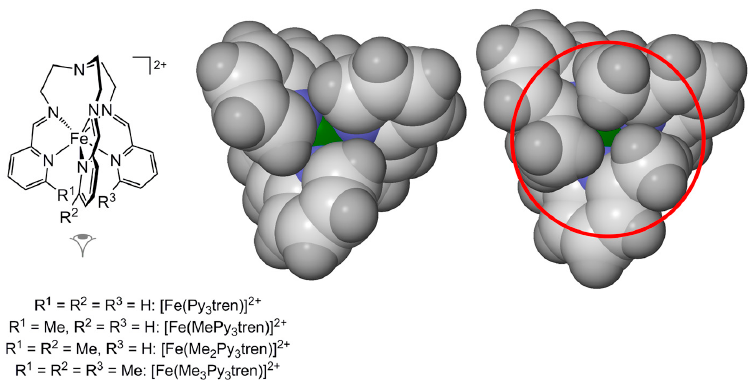
Figure 1. [Fe(Py 3 tren)] 2+ and its methylated derivatives ( left ); and crystallographic space-filling views of [Fe(Py 3 tren)] 2+ (center) and [Fe(Me 3 Py 3 tren)] 2+ ( right ) highlighting the steric influence of the methyl substituents in the latter compound [27,28]. The orientation of the space-filling views is indicated in the structure diagram. Color code: C, white; H, pale gray; Fe, green; N, blue. Other studies that have drawn similar conclusions, based on solution measurements, involve the compounds shown in Scheme 4. The SCO equilibrium for [Co(R 2 impy) 2 ] 2+ in (CD 3 ) 2 CO shifts to lower temperature according to the trend R = Bn > i Pr ≈ Tol > t Bu (the tert butyl complex remains high- spin at all temperatures) [29]. The low-spin complex [Fe(bipy) 3 ] 2+ becomes fully high-spin when methylated at the pyridyl C 6 positions, as in [Fe(mbpy) 3 ] 2+ [30] and [Fe(dmbpy) 3 ] 2+ [31]. A series of iron(II) complexes based on tetradentate tris -(pyrid-2-ylmethyl)amine (tpa), [Fe(tpa)(NCMe) 2 ] 2+ , also shows steadily increasing stabilization of the high-spin state as the tpa pyridyl C 6 atoms are sequentially methylated [32]. The SCO equilibrium temperatures in the scorpionate complexes [Fe(HB{pz} y {dmpz} 3 ‒ y ) 2 ] shift progressively to higher temperature as the number of methyl groups in the complex increases, with fully substituted [Fe(HB{dmpz} 3 ) 2 ] being high-spin [33–35]. The hexadentate ligand complex [Fe(tpen)][ClO 4 ] 2 is SCO-active in solution ( T ½ = 363 K in dmf), while its dimethylated analogue [Fe(btpen)][ClO 4 ] 2 remains high-spin at all temperatures [36]. The unsubstituted macrocyclic complex [Fe(Pytacn)(NCMe) 2 ] 2+ is predominantly low-spin at room temperature in CD 3 CN, but three analogues [Fe(Py 6 − R tacn)(NCMe) 2 ] 2+ bearing substituents at the pyridyl C 6 position are all high-spin under the same conditions [37]. Unsubstituted [Fe(1-bpp) 2 ] 2+ (Scheme 2) is SCO-active, with T ½ = 248 K in (CD 3 ) 2 CO [38], but [Fe(R 2 -1-bpp) 2 ] 2+ are fully high-spin in the same solvent when R = Ph or i Pr [39]. The same trend is shown by the isomeric 3-bpp complex series, in that [Fe(3-bpp) 2 ] 2+ itself (Scheme 2) is SCO-active [5] but four [Fe(R 2 -3-bpp) 2 ] 2+ derivatives with R ≠ H are all fully high-spin [40]. Like most derivatives of [Fe(terpy) 2 ] 2+, [Fe(terpy) 2 ] 2+ itself is low-spin when R = H, but [Fe(Ph 2 terpy) 2 ] 2+ undergoes SCO ( T ½ ≈ 300 K in EtCN solution) [41].